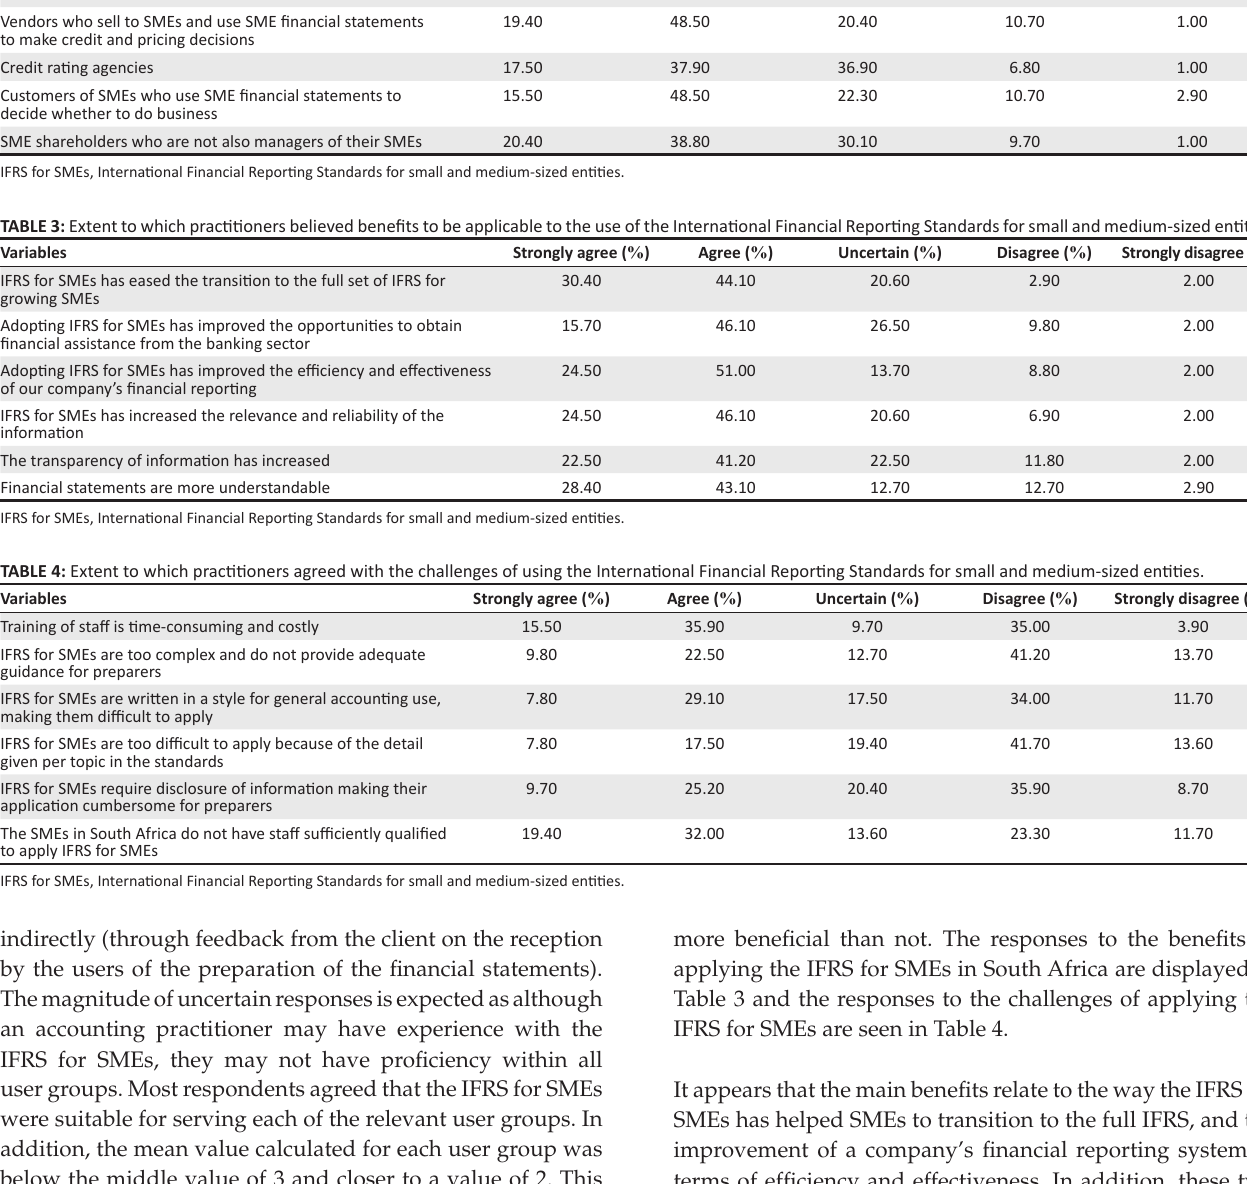
TABLE 2: Extent to which the International Financial Reporting Standards for small and medium-sized entities had addressed the reporting requirements of its intended users .